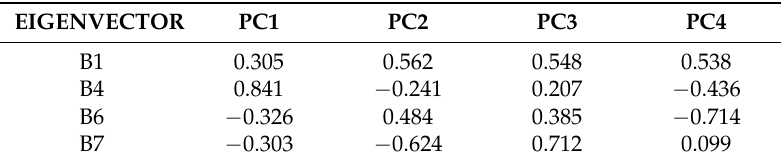
Table 3. Eigenvector statistics for ASTER bands 1, 4, 6 and 7. PC4 shows a greater spectral contrast between bands thus minimizing the response from minerals other than kaolinite.